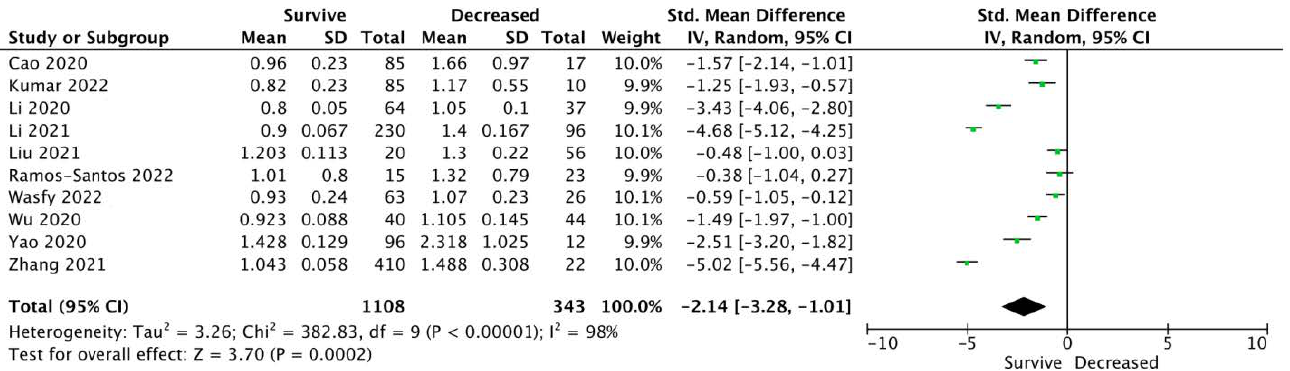
Figure 2. Forest plot of Cystatin C levels among COVID-19 survive vs. decrease patients. The center of each square represents the standard mean differences for individual trials, and the corresponding horizontal line stands for a 95% confidence interval. The diamonds represent pooled results. Legend: CI: confidence interval; SD: standard deviation [21,24–26,28,29,35,36,39,42].